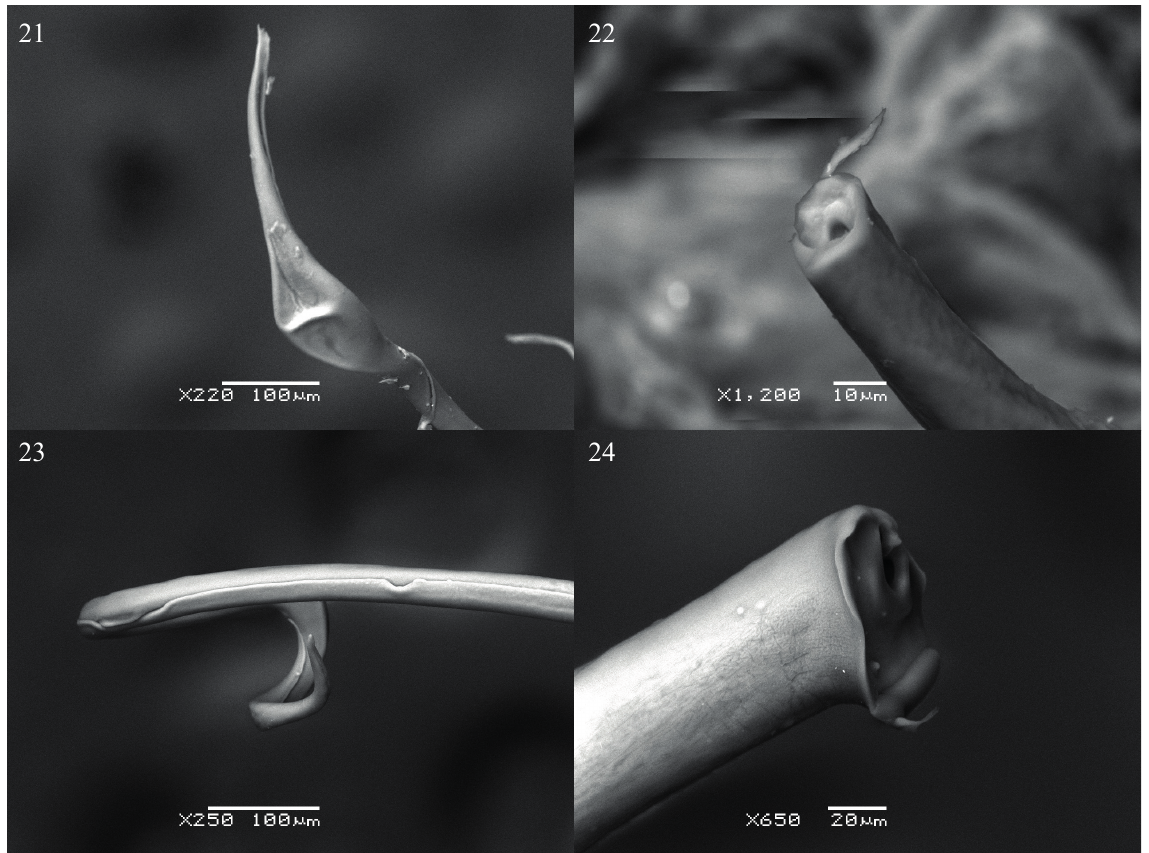
Figs 21–24. SEM details of the apex of the flagellum. 21 . Timarcha tenebricosa (England, Cambridgeshire). 22 . T. goettingensis (Austria, Umgeb. Wien). 23 . T. balearica (Spain, Palma de Mallorca). 24 . T. (Americanotimarcha) intricata (U.S.A., Oregon, East Fork, Dairy